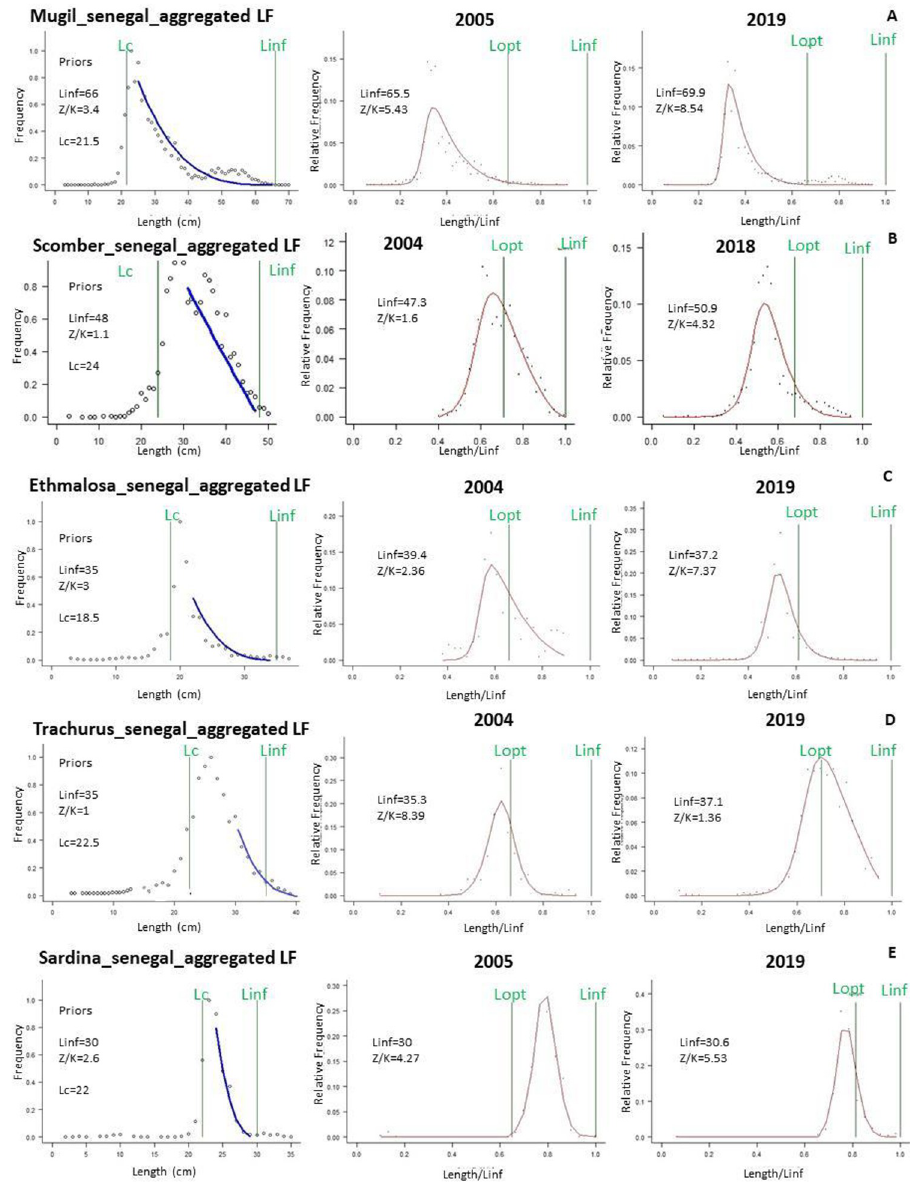
Fig 3. Graphical outputs of LBB analyses, showing the fit of the main LBB equation (see Table 2). The blue line (left) represents the fit of the data and the LBB estimation, and the red line (right) is the evaluation from the LBB method of stock resources. Fitness to the fully selected part of the catch in the numbers curve used to obtain L L c (cm), and Z/K priors for Mugil cephalus (A), Scomber colias (B), Ethmalosa fimbriata (C), Trachurus trecae (D), and Sardina pilchardus (E). Black dots indicated the observed LF data (total length). L opt and L inf were illustrated by green